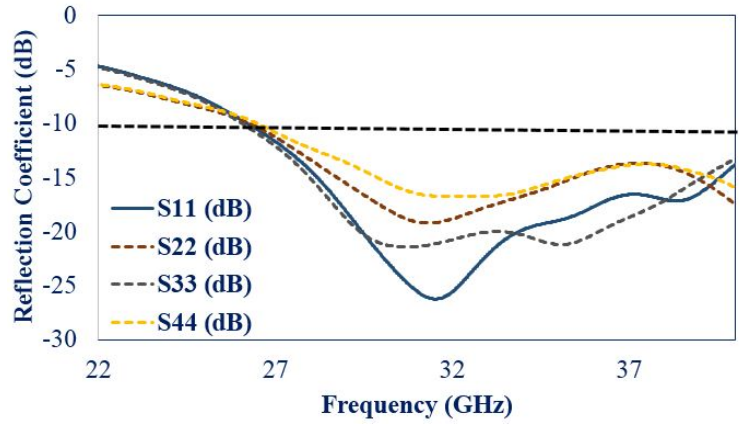
Figure 9. Reflection coefficient results for four-port MIMO antenna.